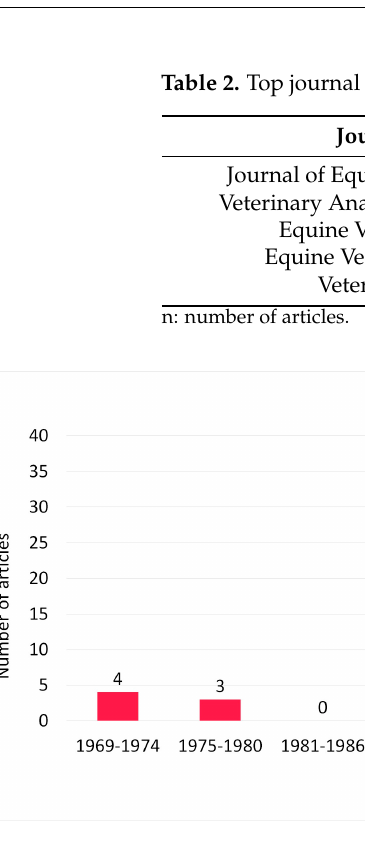
Figure 2. Distribution of studies published by 6 year intervals (n = 87).